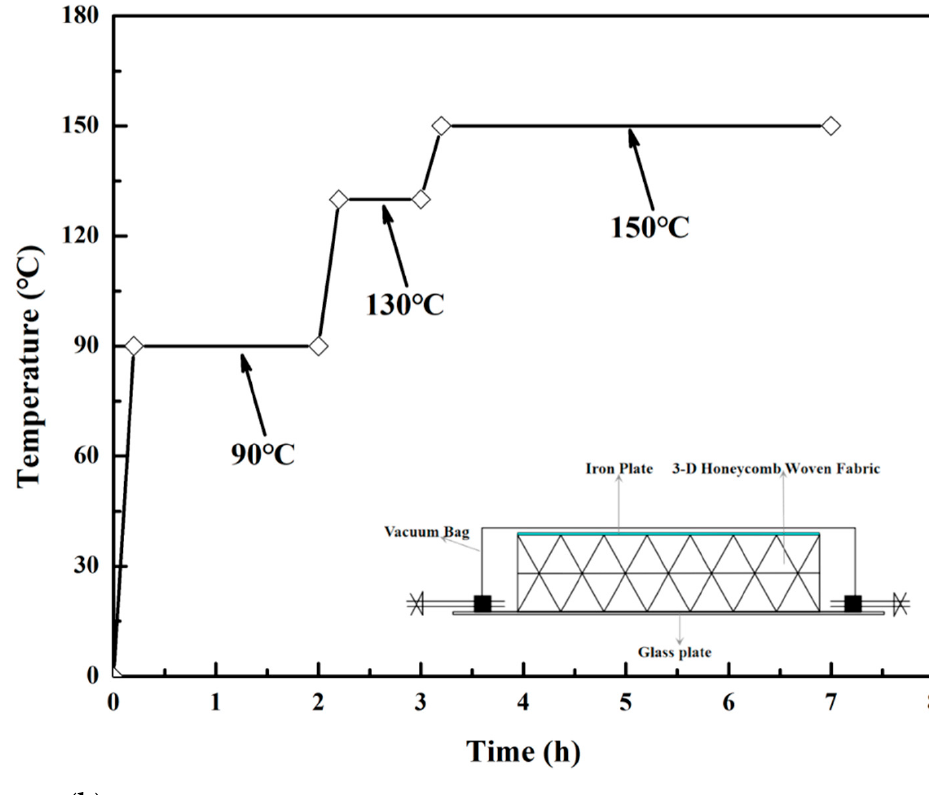
Figure 3. ( a ) Schematic diagram of VARTM process; ( b ) high-temperature curing process diagram of the 3-D honeycomb woven EM absorbing composite.